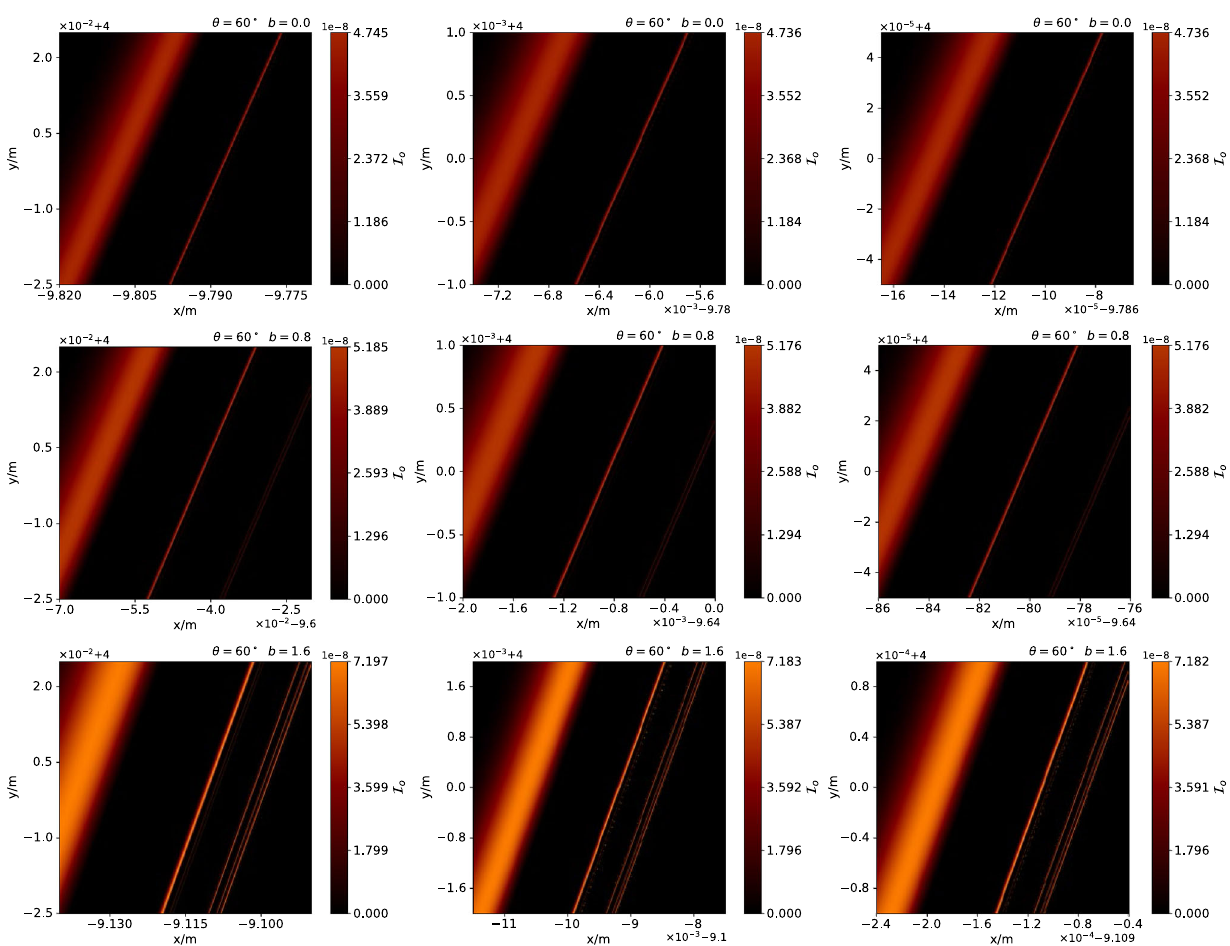
Fig. 5 Enlarged image near secondary image with θ 0 = 60 ◦ for different b . The panels from the top to bottom denote the cases with b = 0, 0 . 8 and 1 . 6,